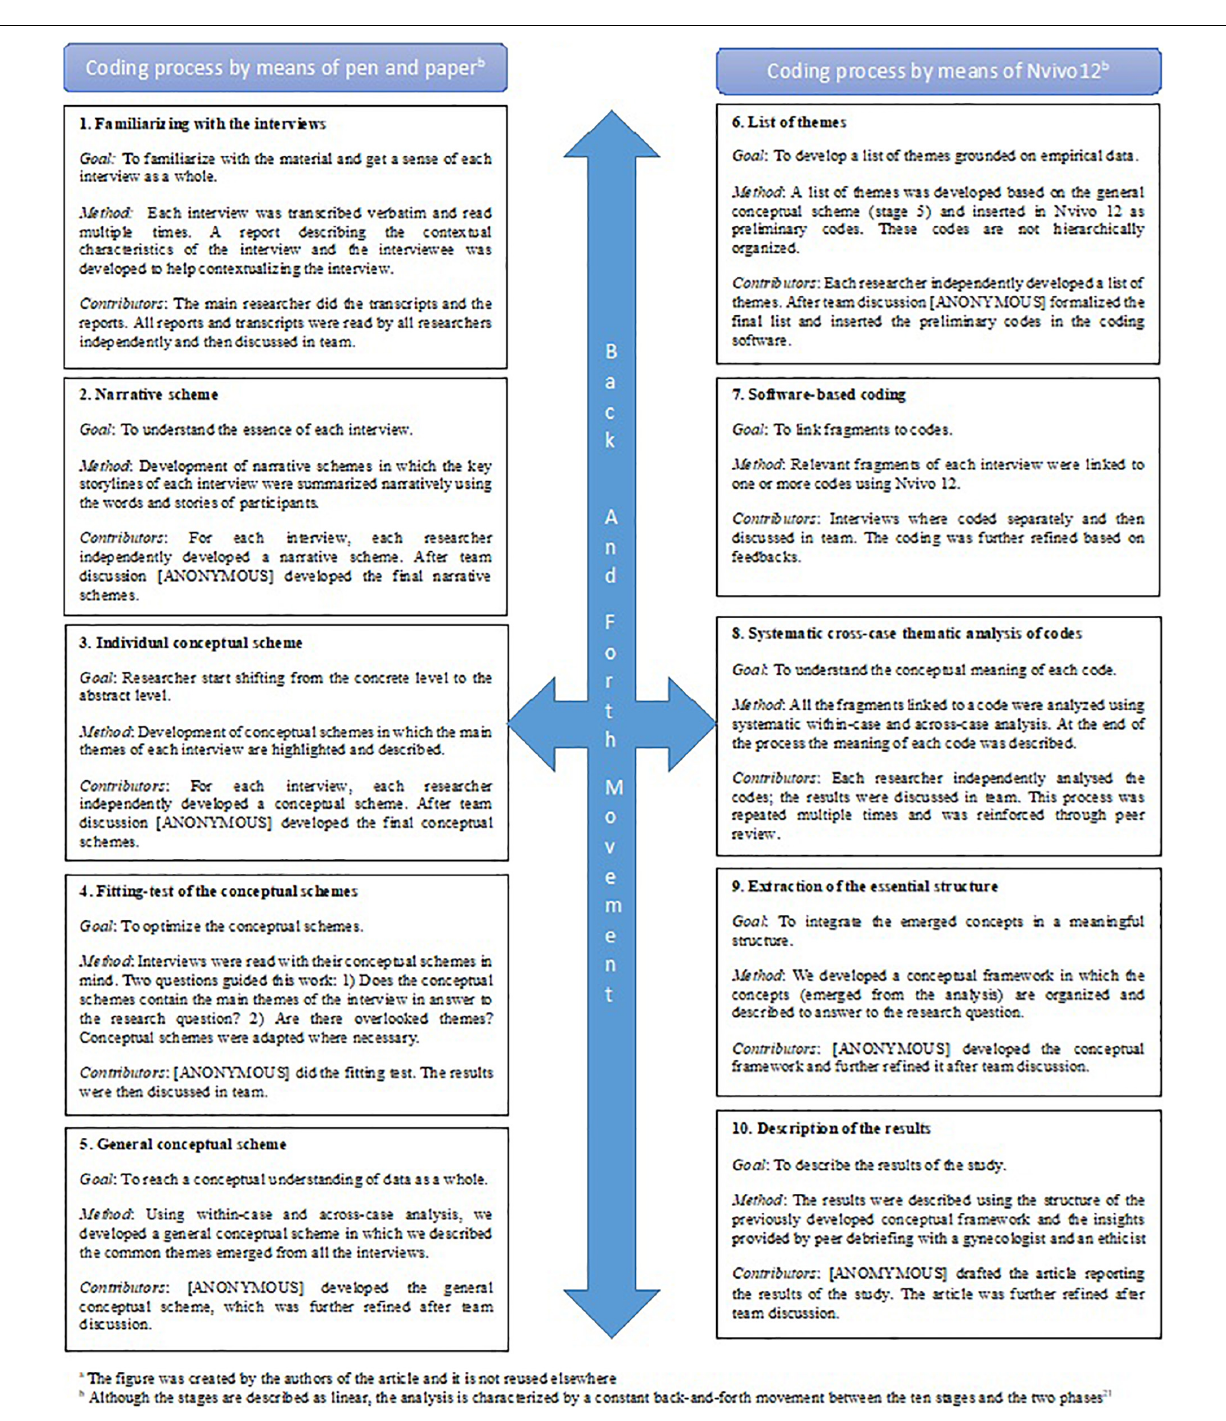
FIGURE 1 | Analysis process by means of Qualitative Analysis Guide of Leuven (QUAGOL) (20, 21) a . a The figure was created by the authors of the article and it is not reused elsewhere. b Although, the stages are described as linear, the analysis is characterized by a constant back-and-forth movement between the 10 stages and the two phases